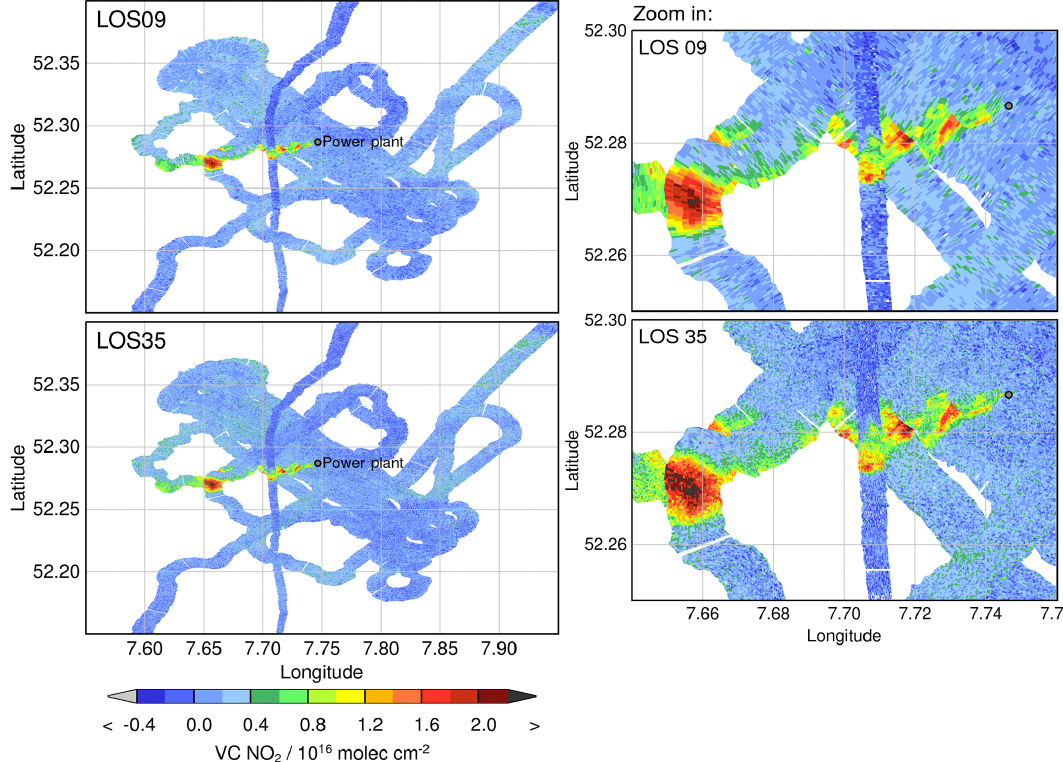
Figure 12. Map of NO 2 vertical columns above the Ibbenbüren power plant exhaust plume for division of the field of view into 9 LOS (top) and 35 LOS (bottom). On the right, a close-up view is shown. The retrieved slant columns from Fig. 9 and AMF from Fig. 11 (albedo 0.05, blue curve) have been used. Good consistency of NO 2 amounts is achieved independent of the LOS